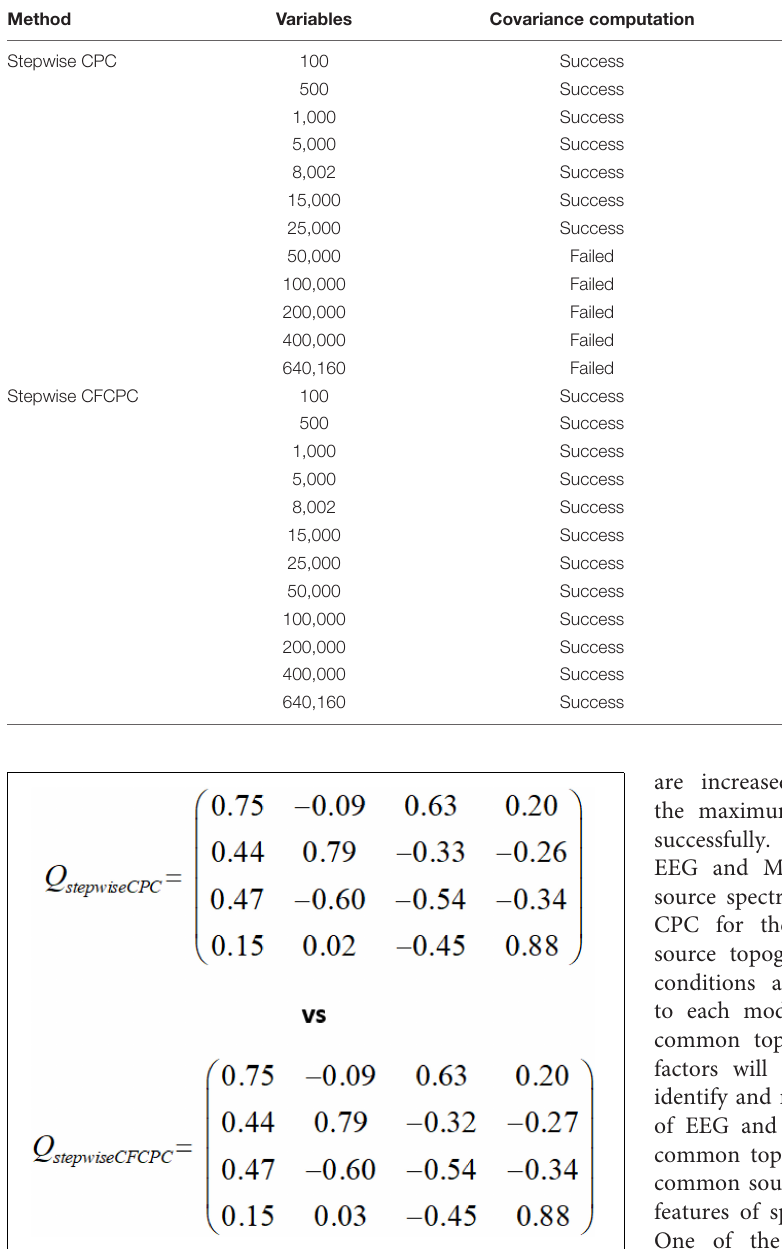
FIGURE 1 | Stepwise CPC vs. covariance free stepwise